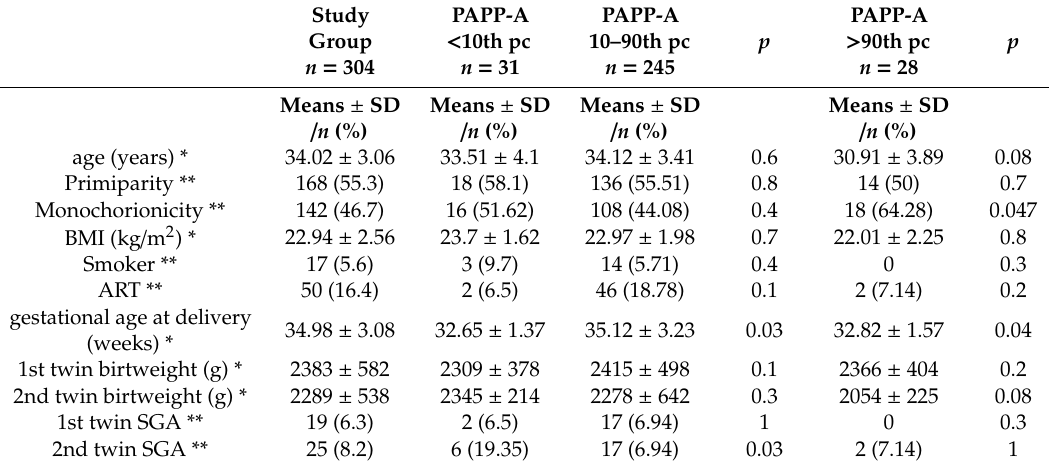
Table 1. Basic characteristics of the study